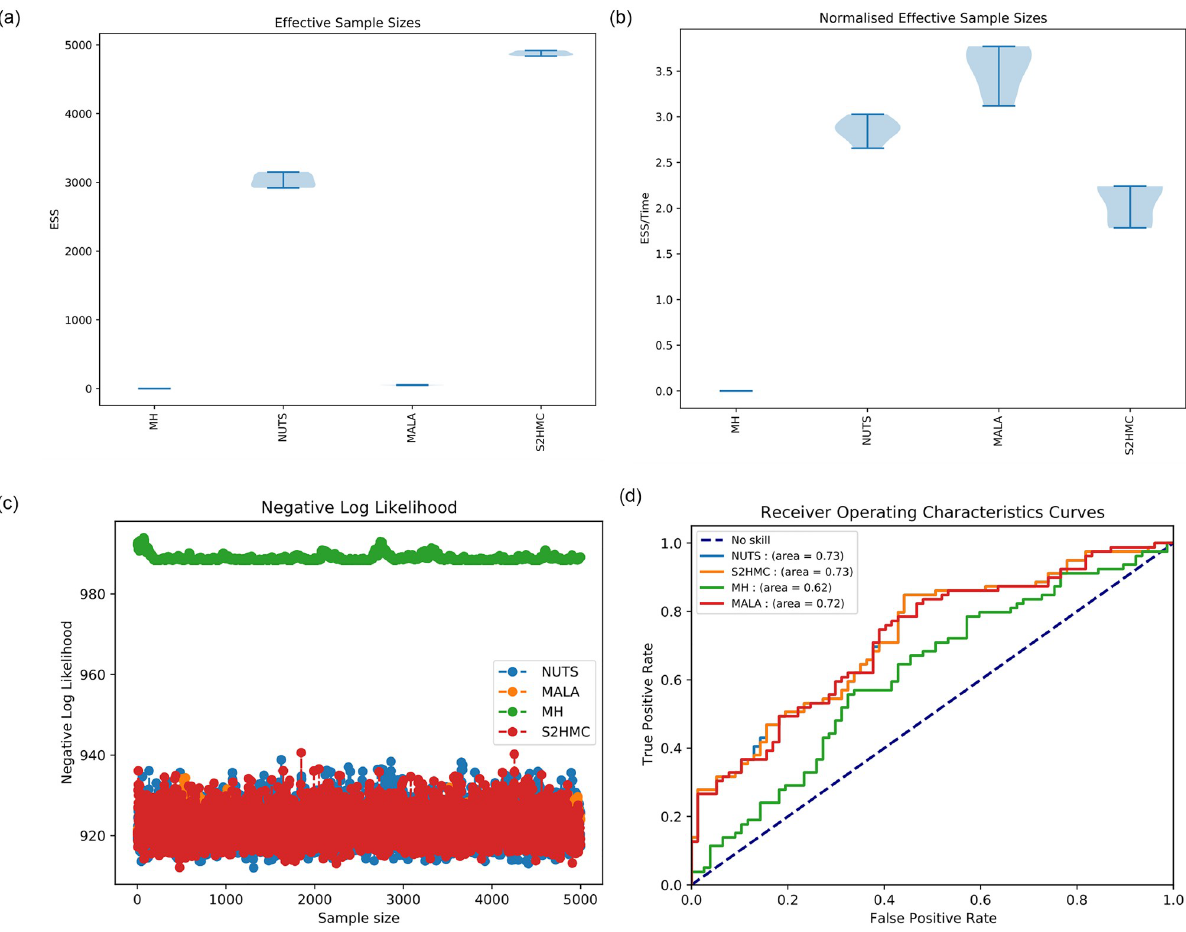
Fig 1. Inference results for the BLR-ARD model across various sampling methods. a) Effective sample sizes, b) Effective sample sizes normalised by execution time, c) Diagnostic negative log-likelihood trace plots and d) Predictive performance based on the Area under the Receiver Operating